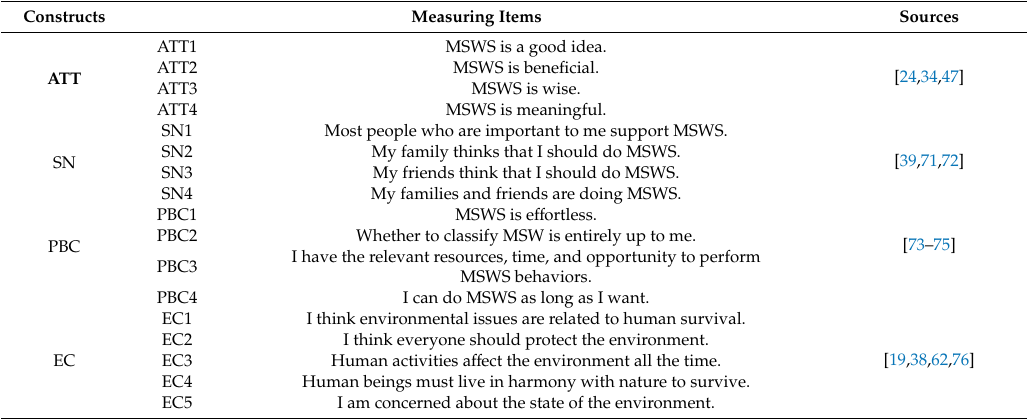
Table 1. Survey items regarding young people’s intention toward